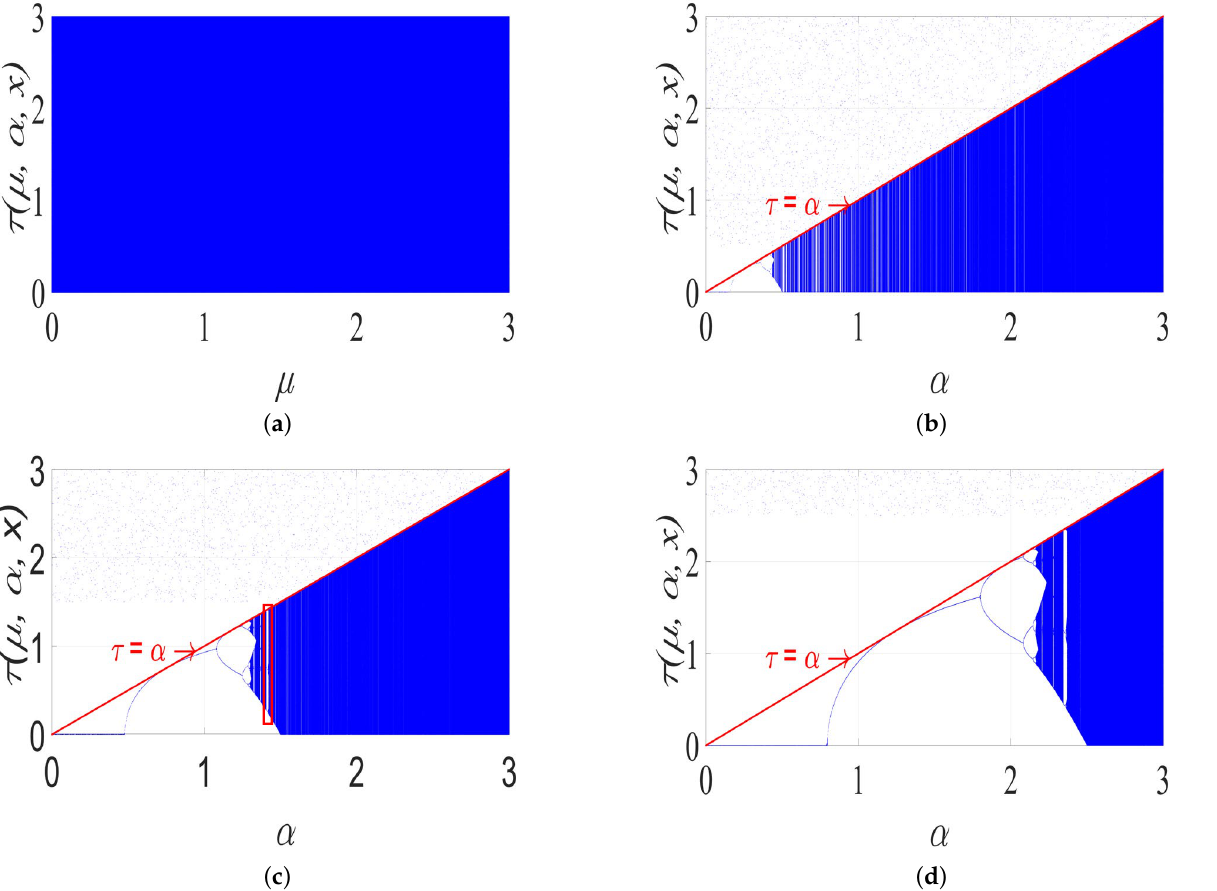
Figure 3. Bifurcation diagram of the FC: ( a ) µ ∈ ( 0,3.0 ) and α = 3.0, ( b ) α ∈ ( 0,3.0 ) and µ = 0.5, ( c ) α ∈ ( 0,3.0 ) and µ = 1.5, and ( d ) α ∈ ( 0,3.0 ) and µ = 2.5. Red lines show the fixed points of the chaotic